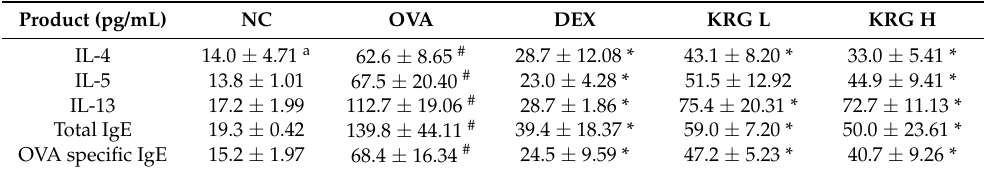
Table 1. Levels of interleukins (IL) and immunoglobulin E (IgE) in bronchoalveolar lavage fluid or serum.